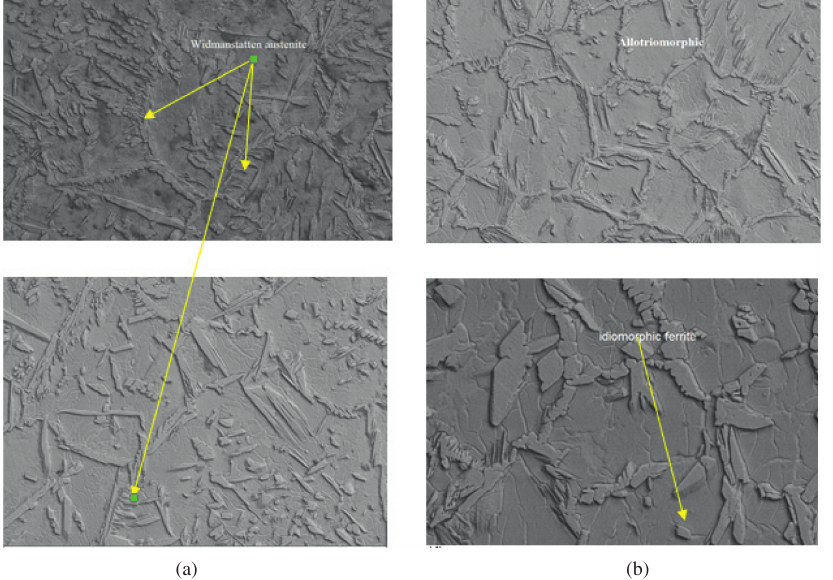
Figure 12: SEM photograph of PAW of duplex SS 2205 showing the various zones (a) Widmanstätten austenite and (b)